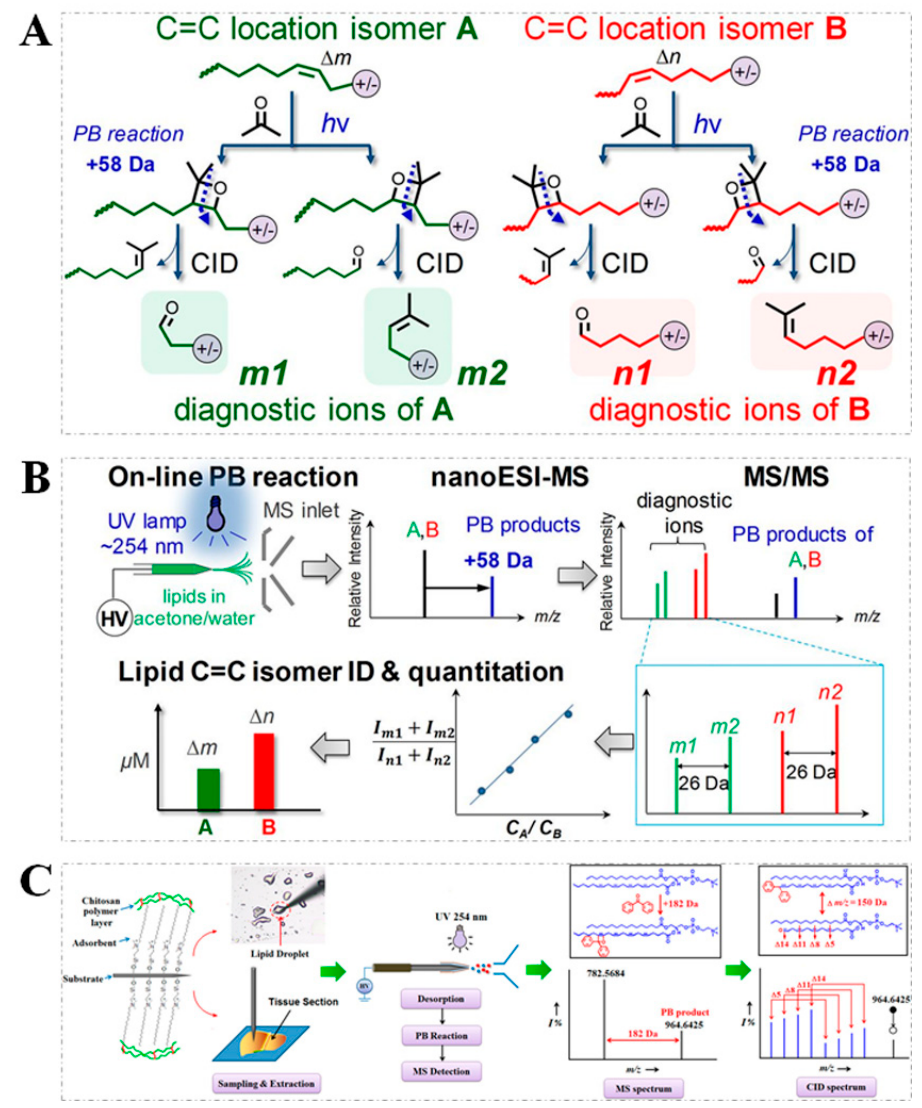
Figure 2. ( A ) The formation mechanism of C = C diagnostic ions from lipid C = C location isomers via PB reaction; ( B ) the workflow of direct characterization and quantitation of lipid C = C location isomers by PB − -nanoESI − MS/MS (note: Figure 2A,B reproduced from Ref. [16] with permission from National Academy of Sciences); ( C ) the workflow of SCP − PB − nanoESI − MS method for in vivo and microscale profiling of lipid characterization in tissue sections (reproduced permission from Ref. [47]. Copyright (2019) American Chemical Society).